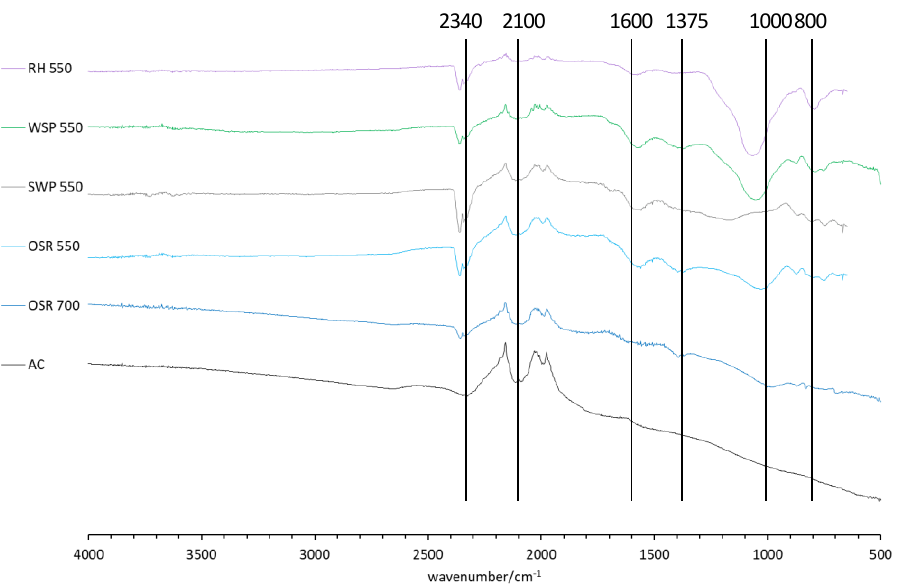
Figure 5. Fourier-transform infrared spectroscopy–attenuated total reflection (FTIR–ATR) spectra for biochars from different feedstocks (rice husk (RH), wheat straw (WSP), soft wood (SWP) and oil seed rape (OSR)) compared with commercial activated carbon (AC). The peaks are attributed to: CO 2 (2340 cm −1 ), C≡C (2100 cm −1 ), aromatic C=C (1600 cm −1 ), phenolic O-H (1375 cm −1 ), Si-O-Si symmetric (1000 cm −1 ) and Si-O-Si asymmetric (800 cm −1 ). Spectra are offset for clarity.